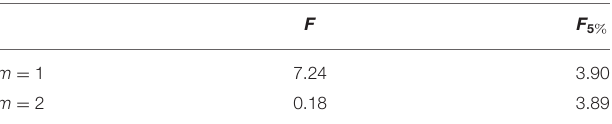
TABLE 6 | Results of the F test.